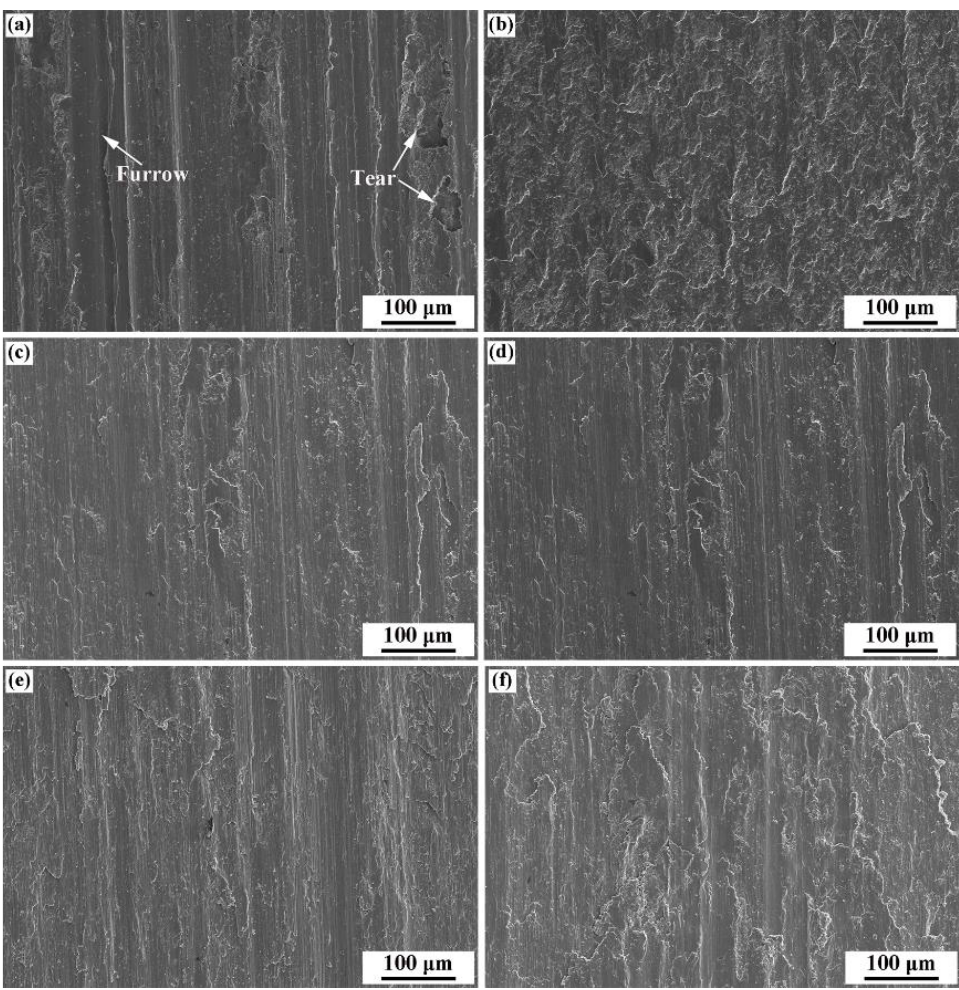
Figure 11. The wear morphologies of ( a ) the Ti6Al4V substrate and composite coatings with various CeO 2 contents: ( b ) 0 wt.%; ( c ) 1 wt.%; ( d ) 2 wt.%;( e ) 3 wt.%; ( f ) 4 wt.%.